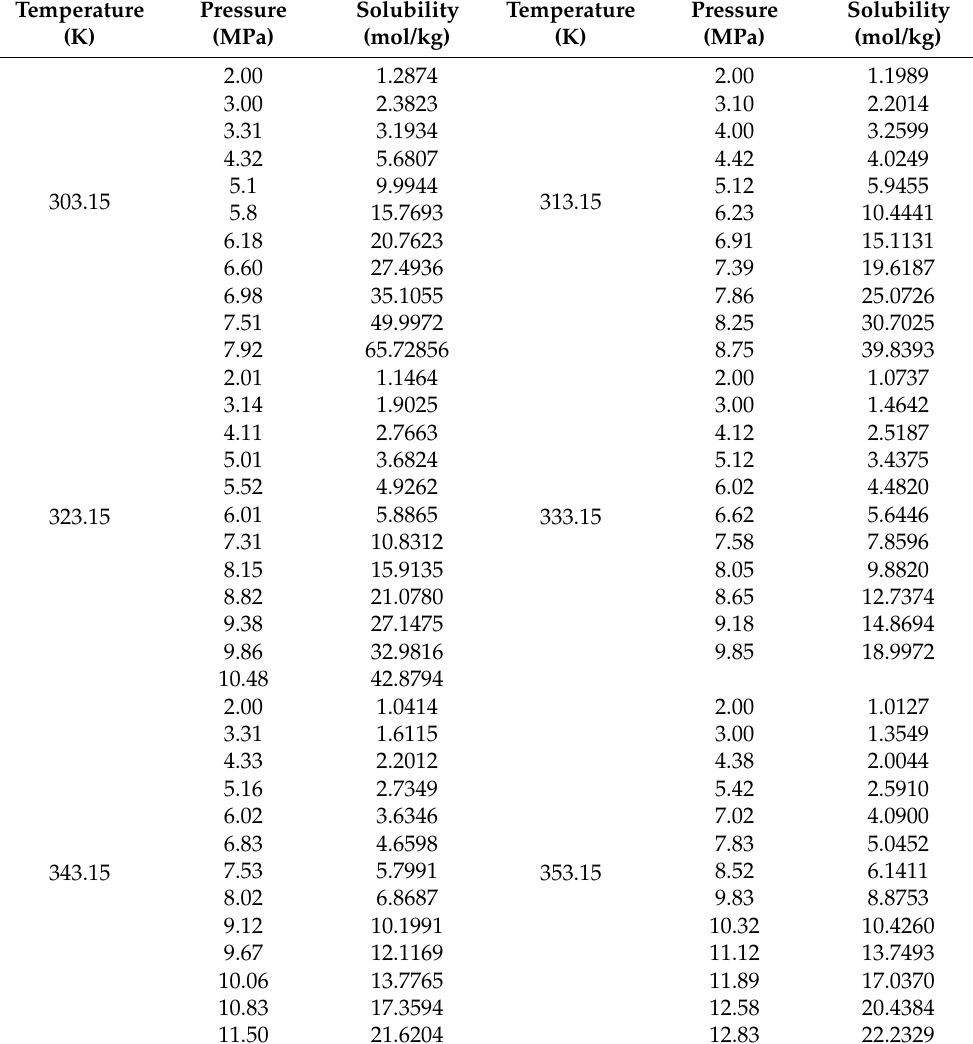
Table 8. The solubility of CO 2 + n -decane + n -hexane system at 303.15~353.15 K and 0~15 MPa. Temperature Pressure Solubility Temperature Pressure (K) (MPa) (mol/kg) (K) (MPa)